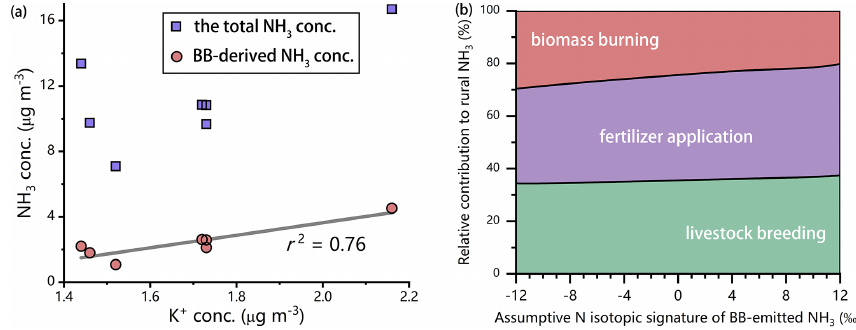
Figure 7. (a) Scatterplots of the aerosol K + concentrations versus total NH 3 concentrations, as well as the NH 3 concentrations from BB emis- sions, at the rural sites during the dry season. (b) Bayesian isotope modeling-based source apportionment results of ambient NH 3 at the rural sites during the dry season, as function of the assumed N isotopic signatures of BB-emitted NH 3